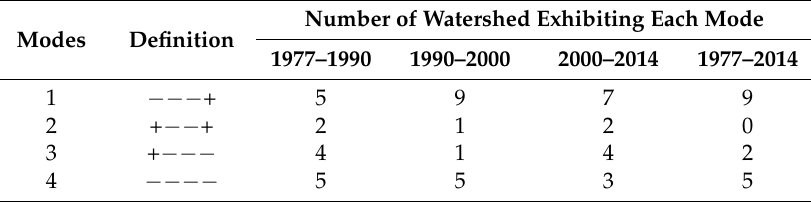
Table 4. Summary of watersheds exhibiting different response modes for different